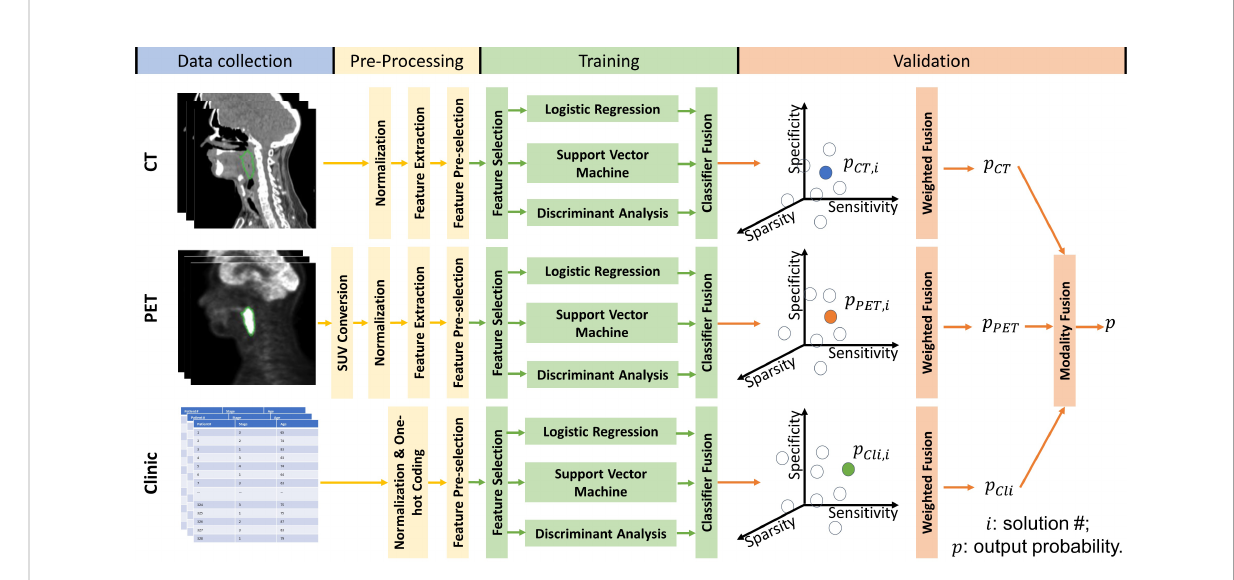
FIGURE 2 Work fl ow for the proposed multi-objective, multi-classi fi er, multi-modality radiomics